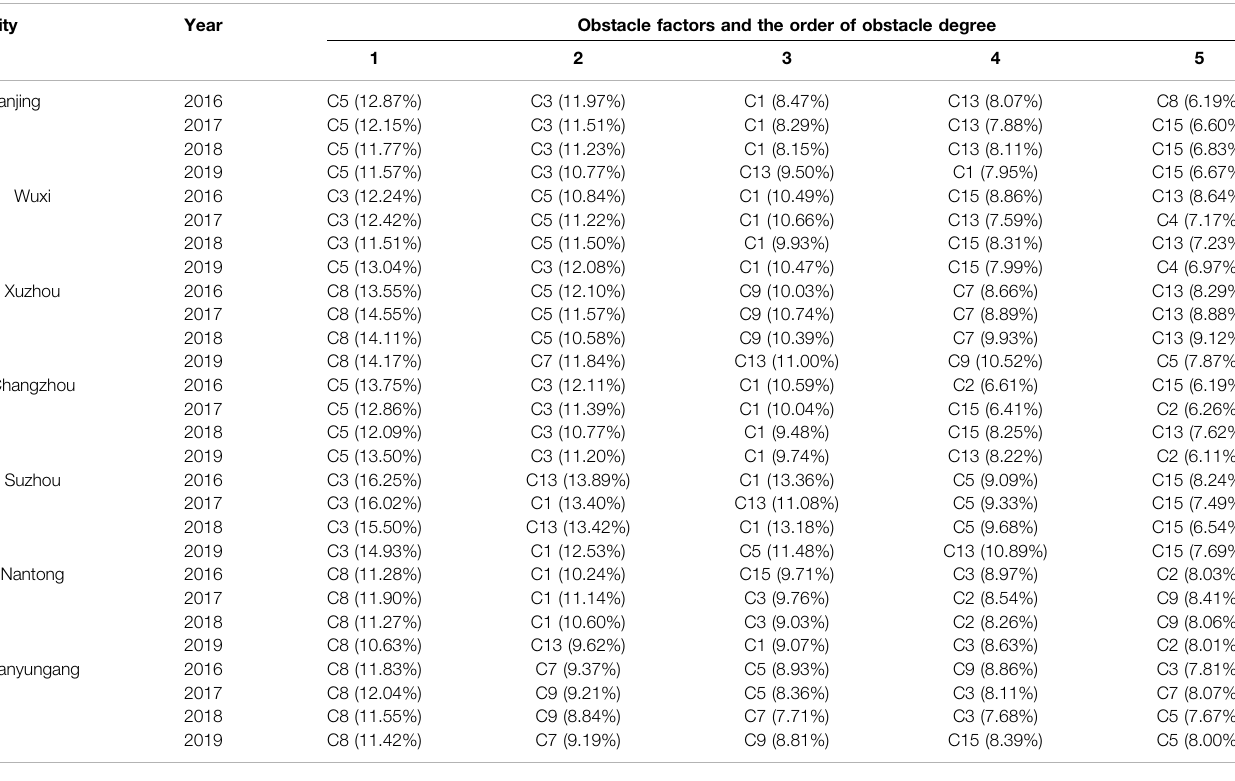
TABLE 4 | Main Obstacle Factors for Sustainable Agriculture in Jiangsu Province and Rank of Obstacle Degree from 2016 to 2019 (Part slowromancapi@) City